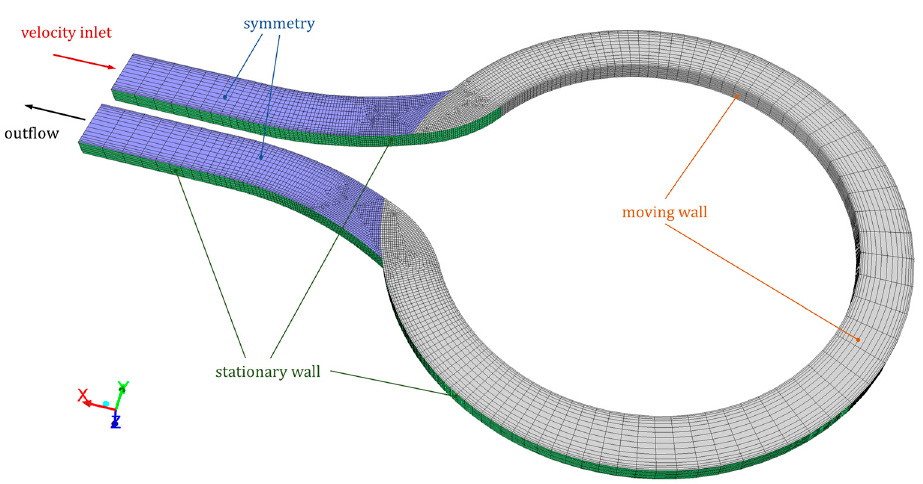
Figure 2. Final geometry of computational domain with boundary conditions and mesh.